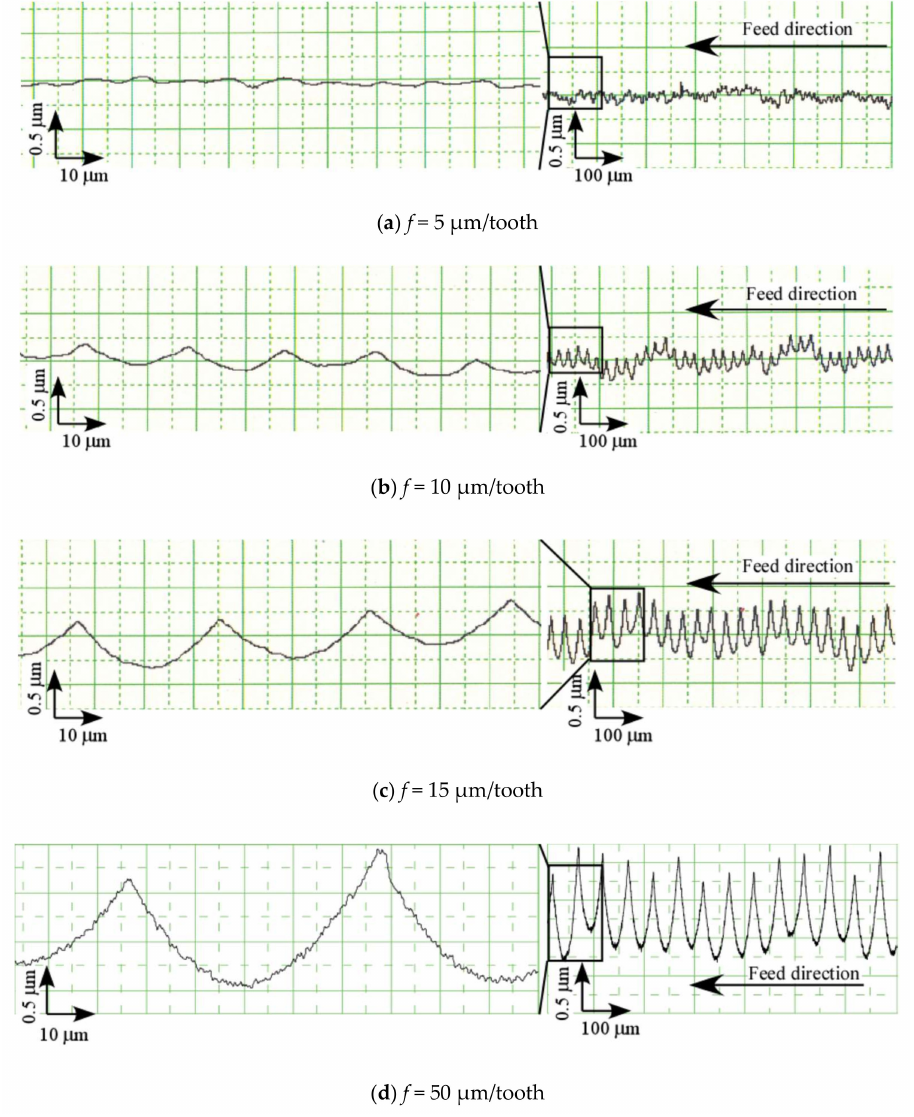
Figure 11. Roughness curves (Up cut, N s = 100,000 min − 1 ), ( a ) f = 5 µ m / tooth, ( b ) f = 10 µ m / tooth, ( c ) f = 15 µ m / tooth, ( d ) f = 50 µ m /